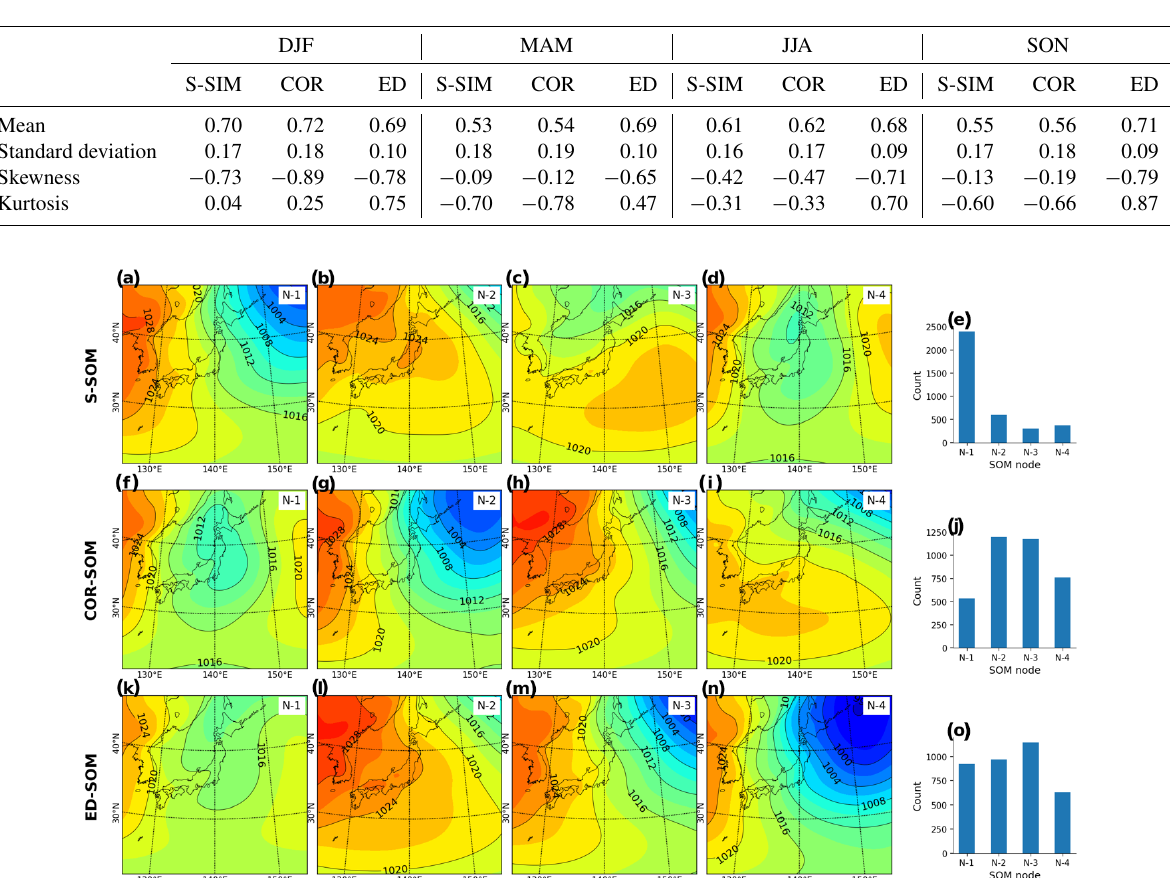
Figure 4. Winter (DJF) MSLP pattern revealed by SOMs. Panels (a) – (d) show S-SOM patterns (with four nodes); panel (e) shows the number of daily MSLPs classified as nodes 1 to 4. Panels (f) – (i) show the same result but for COR-SOM; (k) – (o) for